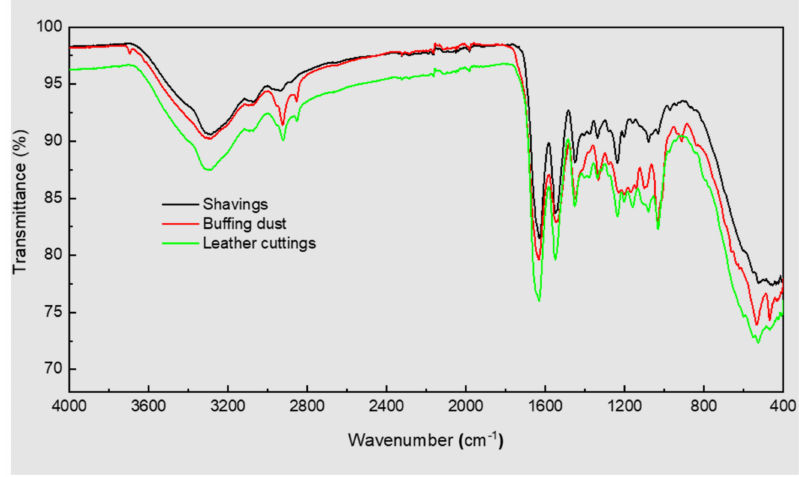
Figure 7. FTIR spectra of collected leather wastes (Adapted from Nur-A-Tomal, et al. [7]. Reproduced with permission from Springer Nature).